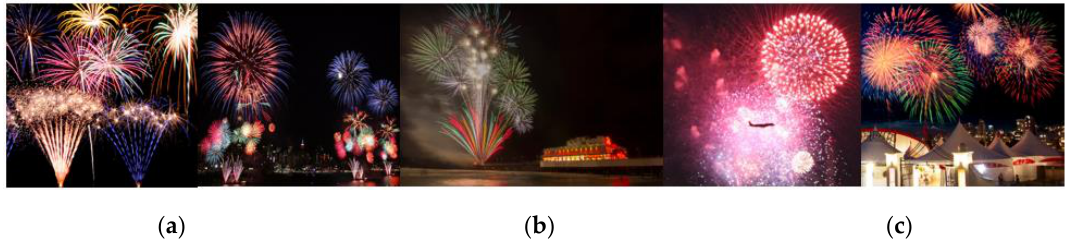
Figure 9. Sample fireworks videos that did not satisfy our data selection conditions. ( a ) Videos containing multiple types of fireworks; ( b ) moving objects like ships and airplanes; ( c ) visible and static objects in the backgrounds.